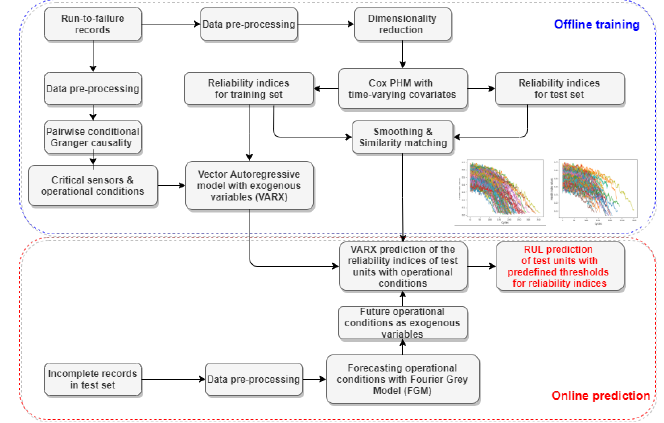
Figure 1. Schematic sketch of the algorithm proposed in this